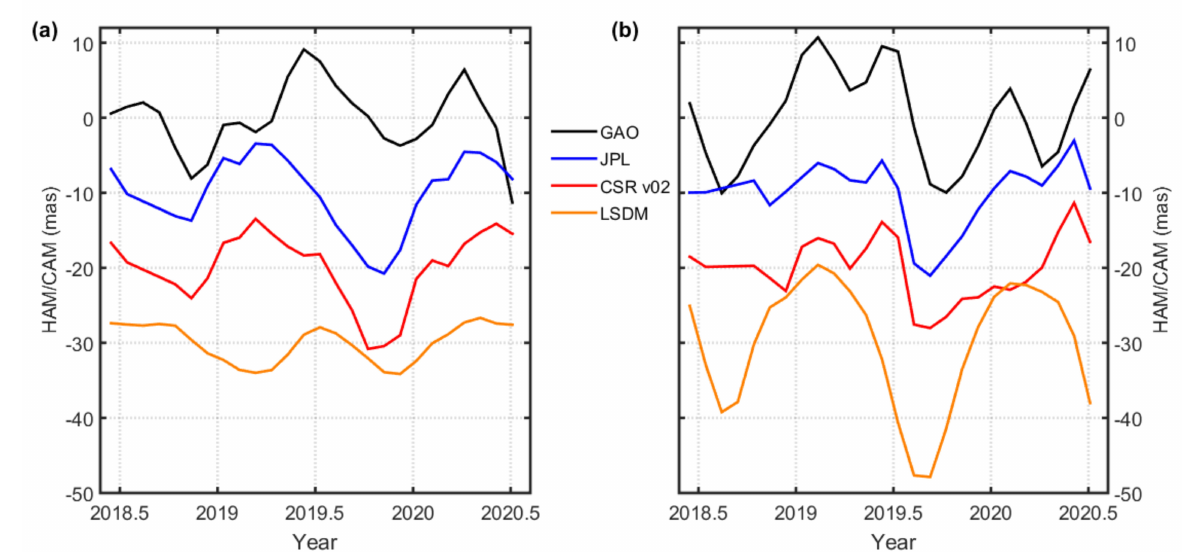
Figure 9. Comparison of overall detrended time series of the ( a ) χ 1 and ( b ) χ 2 components of GAO, GRACE-FO-based HAM/CAM, and LSDM-based HAM.